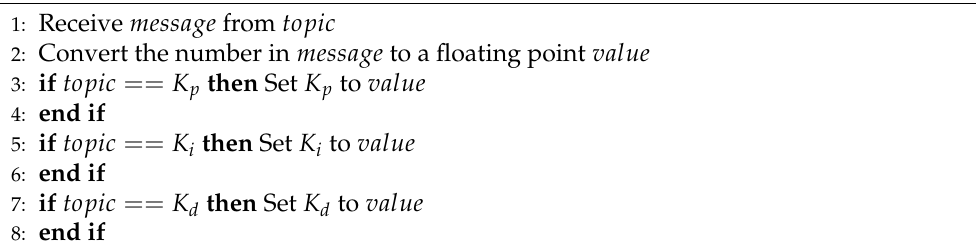
Algorithm 1 Example of MQTT routine to change PID parameters.